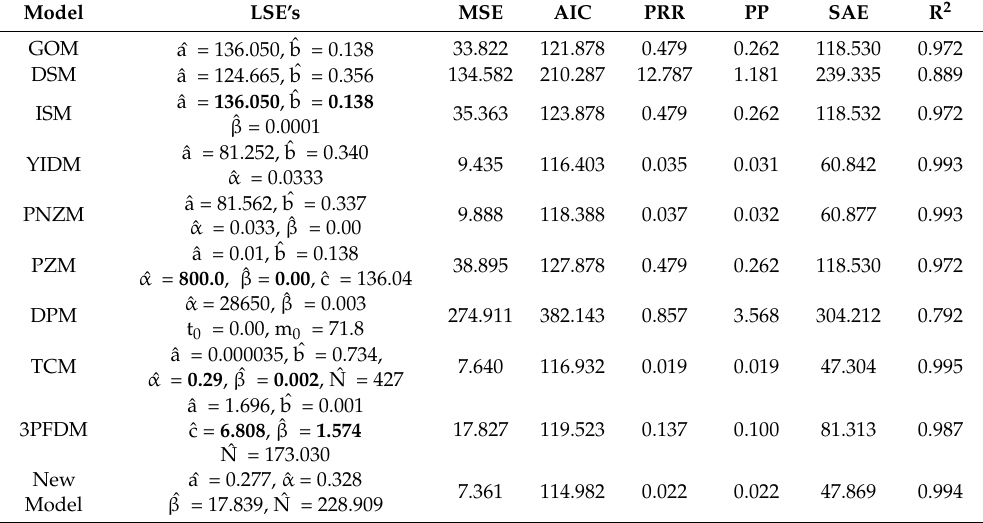
Table 5. Model parameter estimation and comparison criteria from RTC&CS data set (DS1). Least-squares estimate (LSE); mean squared error; Akaike’s information criterion (AIC); predictive ratio risk (PRR); predictive power (PP), sum absolute error (SAE), correlation index of the regression curve equation (R 2 ).